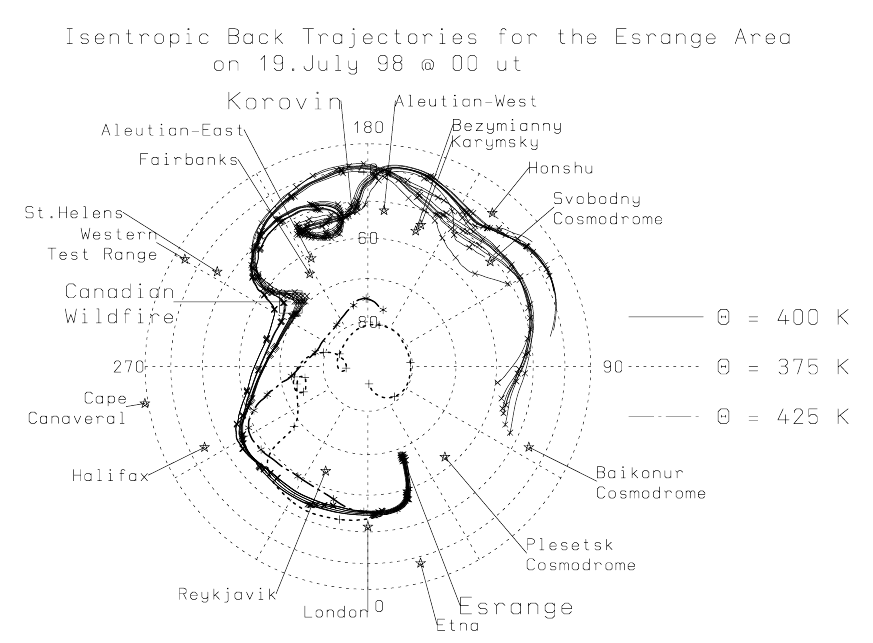
Fig. 3. Isentropic back trajectories ending above Esrange at 0 UT on July 19, 1998 at the cloud level 400 K and 25 K above and below the cloud level (approximately 1–2 km